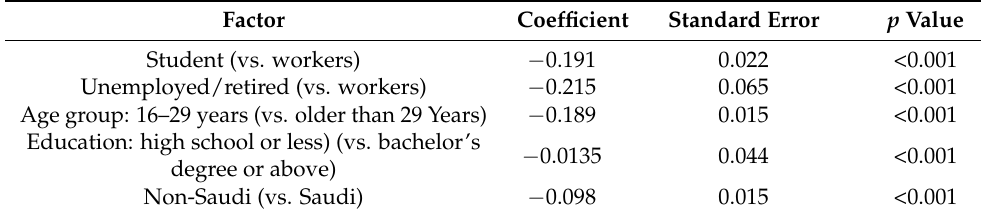
Table 3. Factors associated with low knowledge of